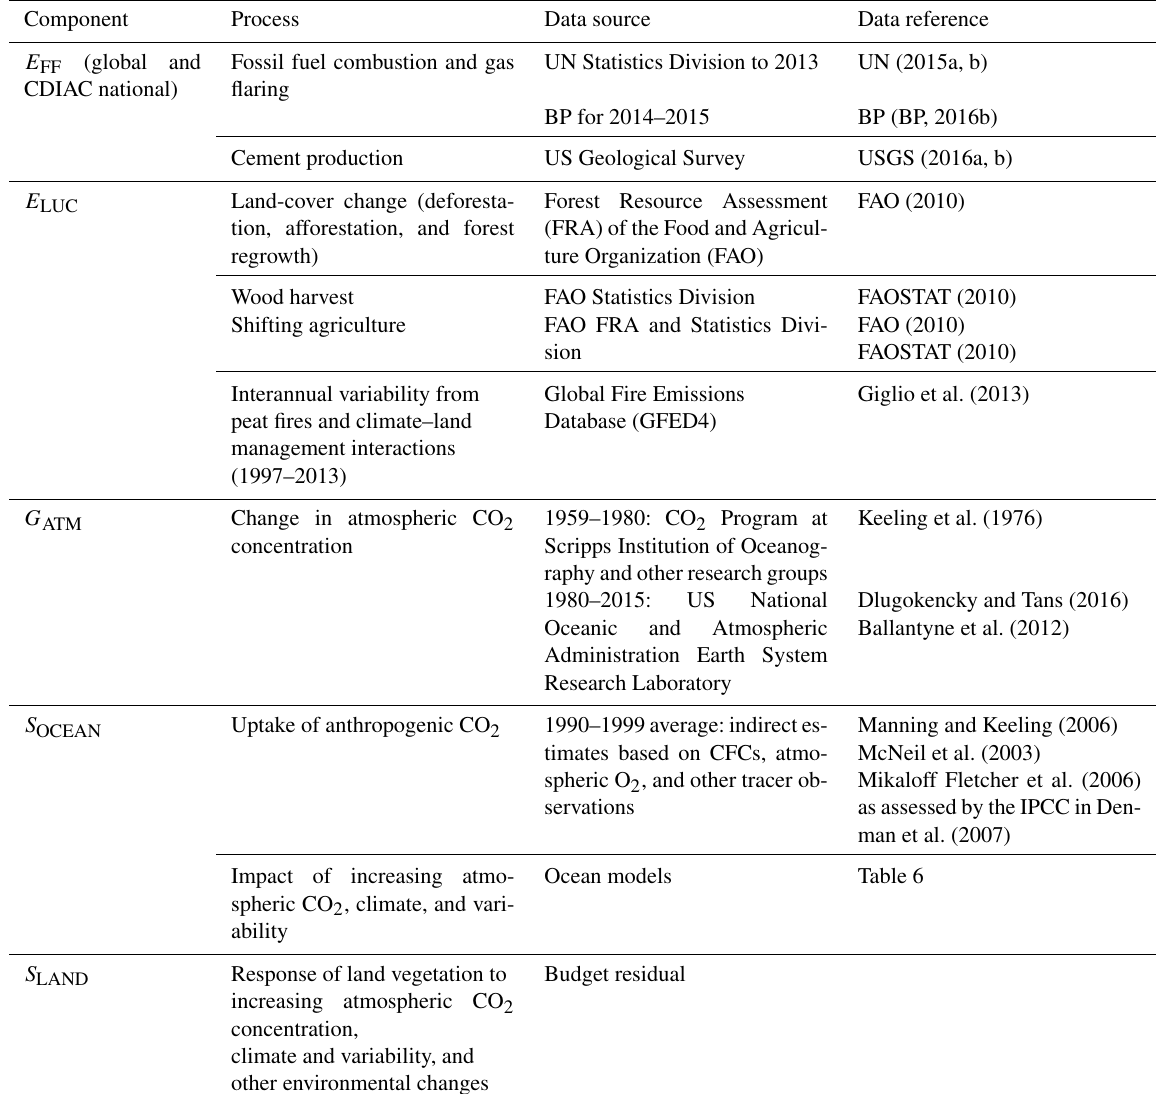
Table 4. Data sources used to compute each component of the global carbon